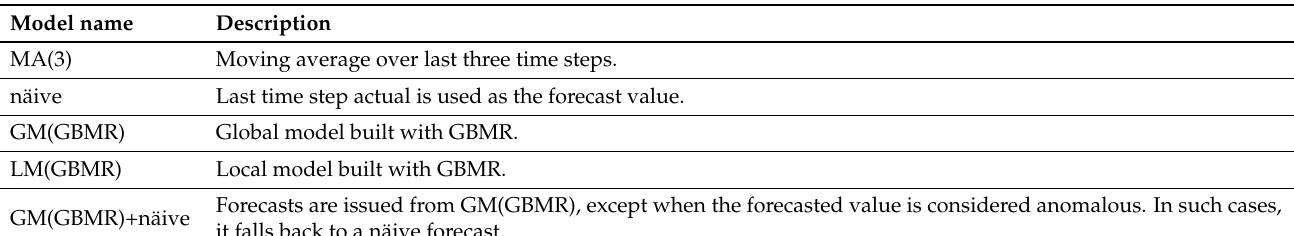
Table 4. Description of the models we evaluated through the experiments that we performed.